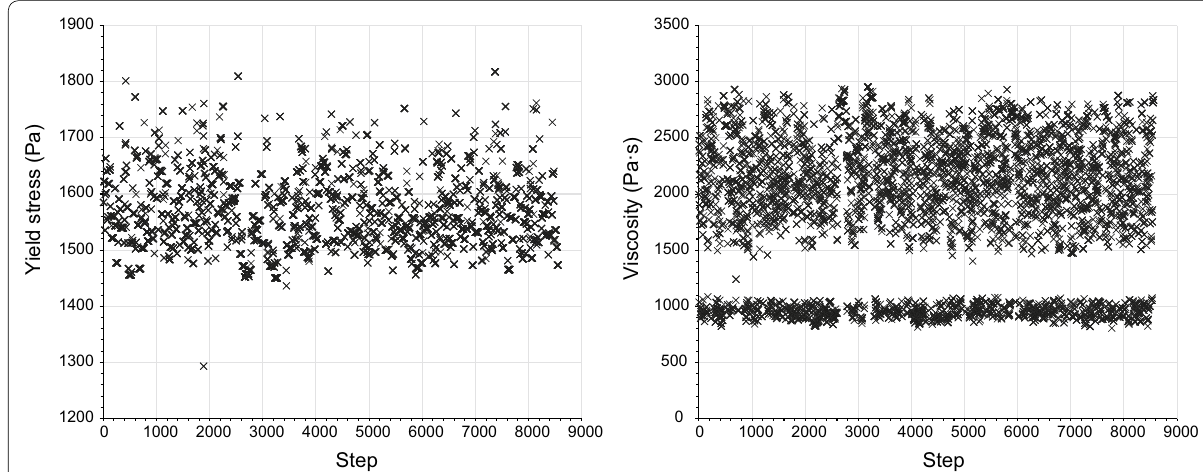
Fig. 4 Behavior of yield stress and viscosity over 8500 MCSs. Left: fitting parameter log 10 ( τ y ) recalculated as τ y . Right: fitting parameter log 10 ( γ r ) recalculated as